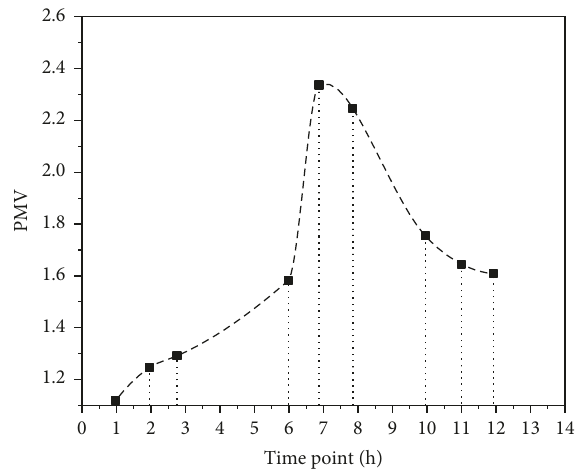
Figure 6: Variation of PMV with time at 29 ° C.